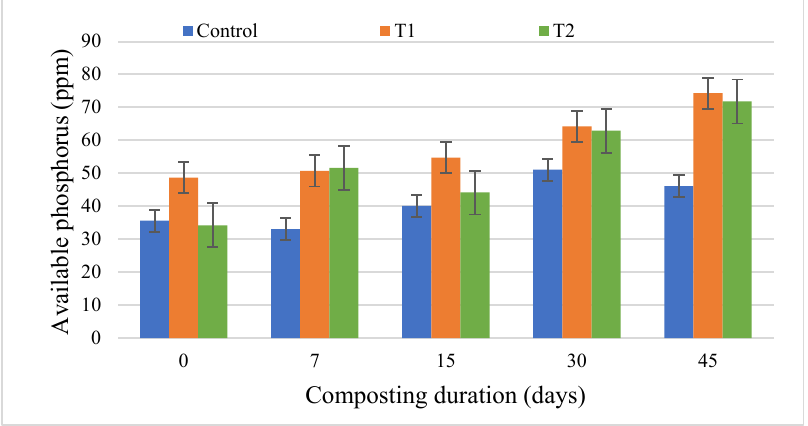
Figure 9. Changes in the levels of available phosphorus in control, T1, and T2 samples at 0, 7, 15, 30, and 45 days.